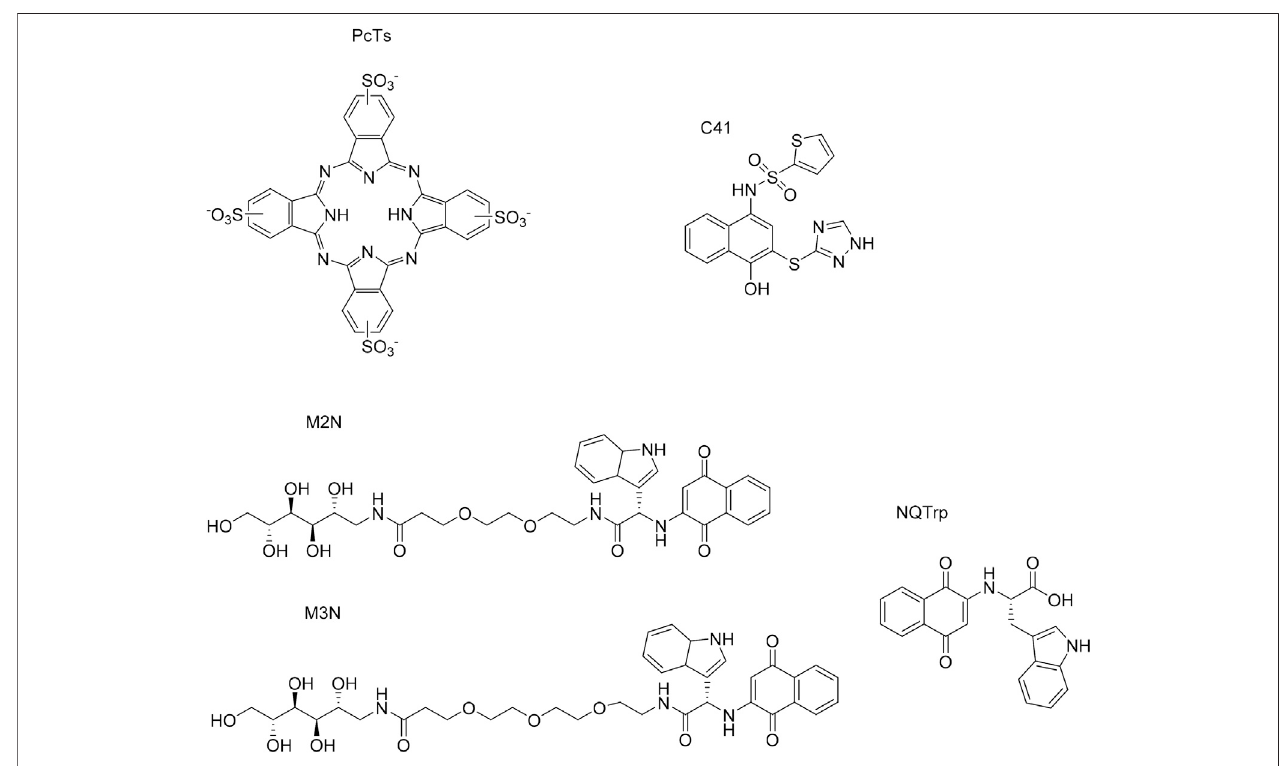
FIGURE 13 | Synthetic small molecules effective on α Syn